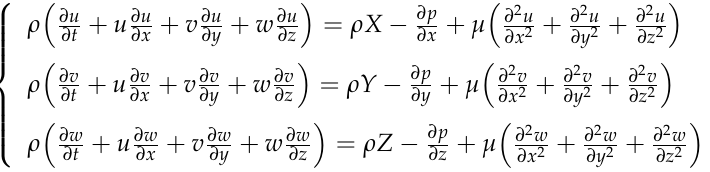
Internal diameter of the annular groove/D 3